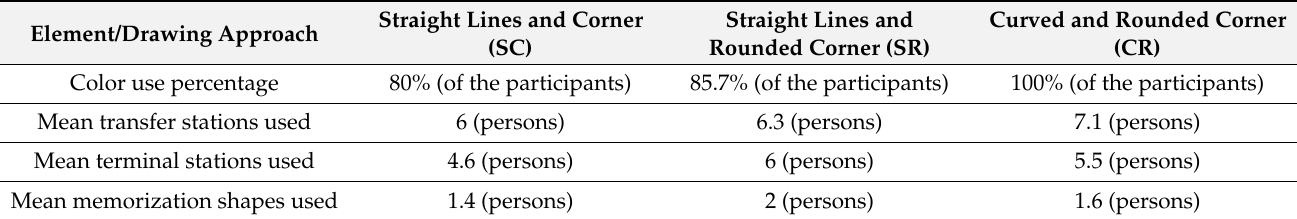
Table 6. Cross comparison of drawing approach and drawing